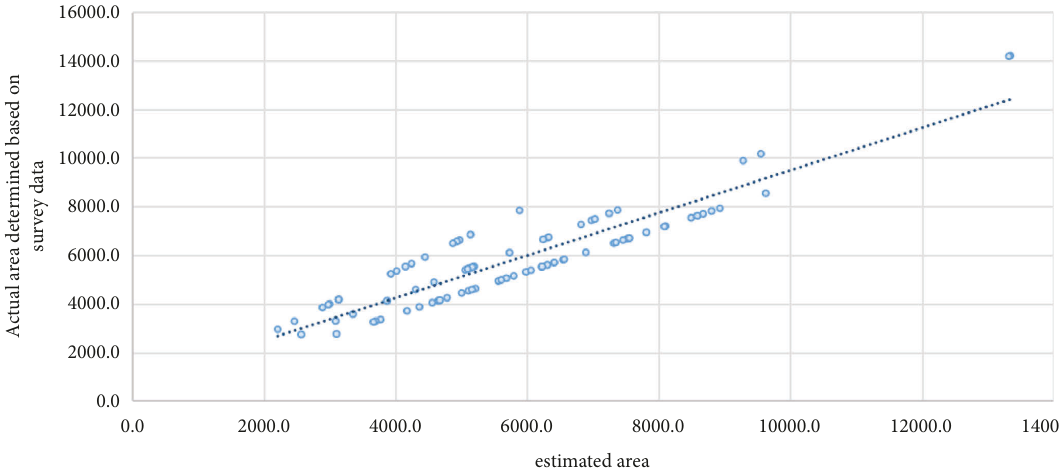
Figure 5: Correlation analysis of actual and estimated building areas.